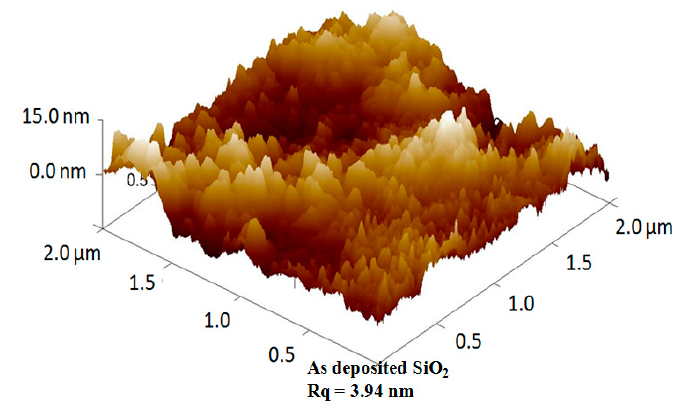
Figure 4. Atomic force microscopy (AFM) image of the e ‐ beam deposited SiO 2 film on indium tin oxide (ITO) glass substrate.